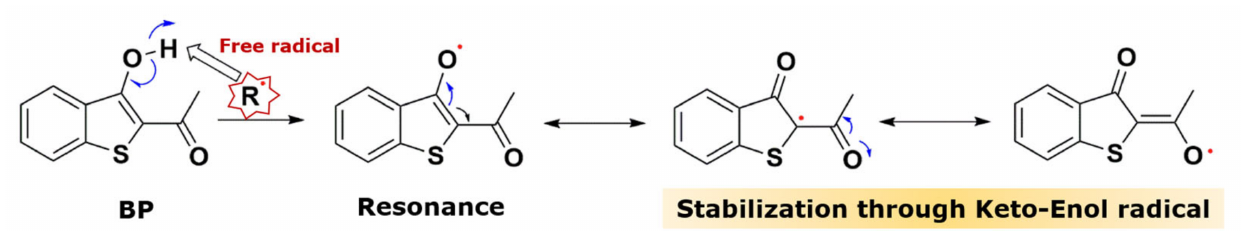
Figure 2. Redox mechanism of analog BP during free radical attack and stabilization through keto- enol radical resonance was denoted using half arrow.